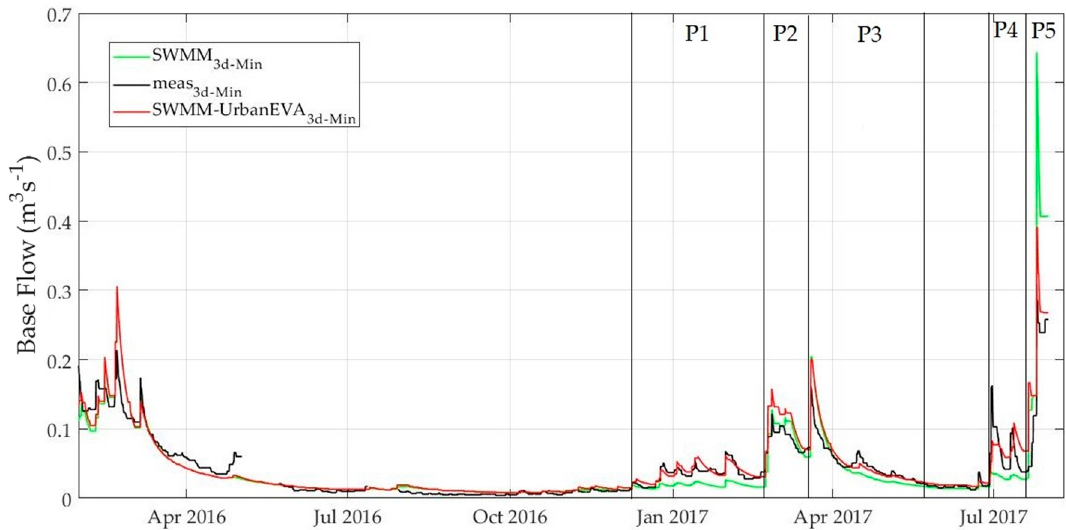
Figure 10. Minimum flows of a 3-day sliding interval of measured data (abbreviation “meas”), flows generated with the official SWMM version and SWMM-UrbanEVA.